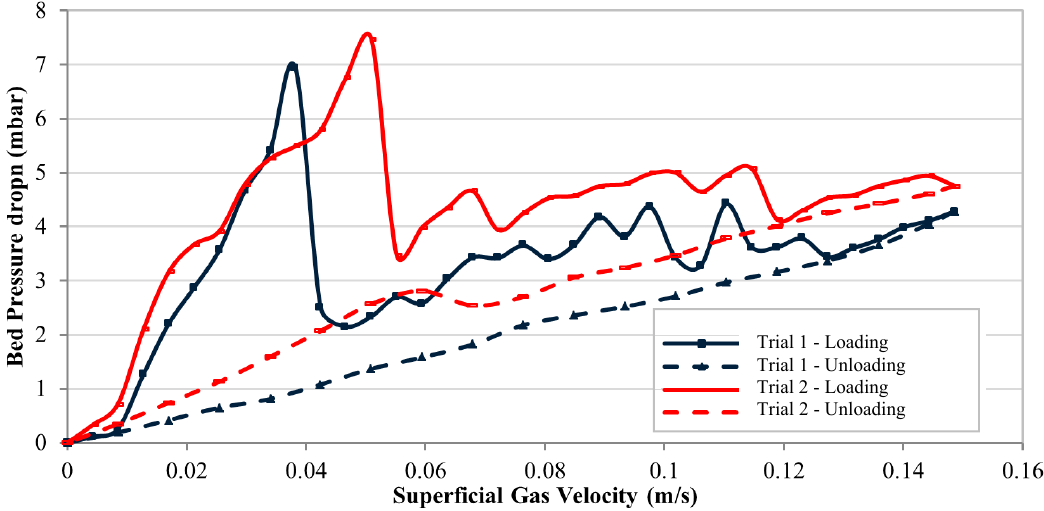
Figure 10. Two independent fluidization tests—loading (—) and unloading ( − − ) of mixed material—(50% of ultra-fine + 50% of fine particles). Processes 2019 , 7 , x FOR PEER REVIEW